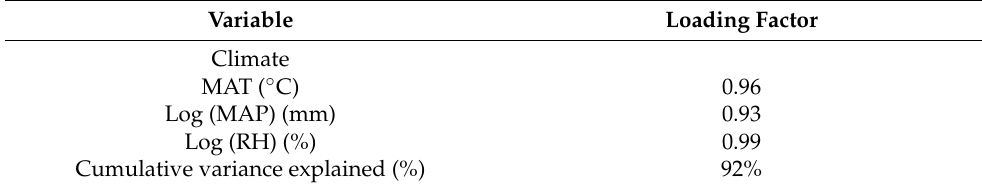
Table A4. Results of PCA of environmental variables.